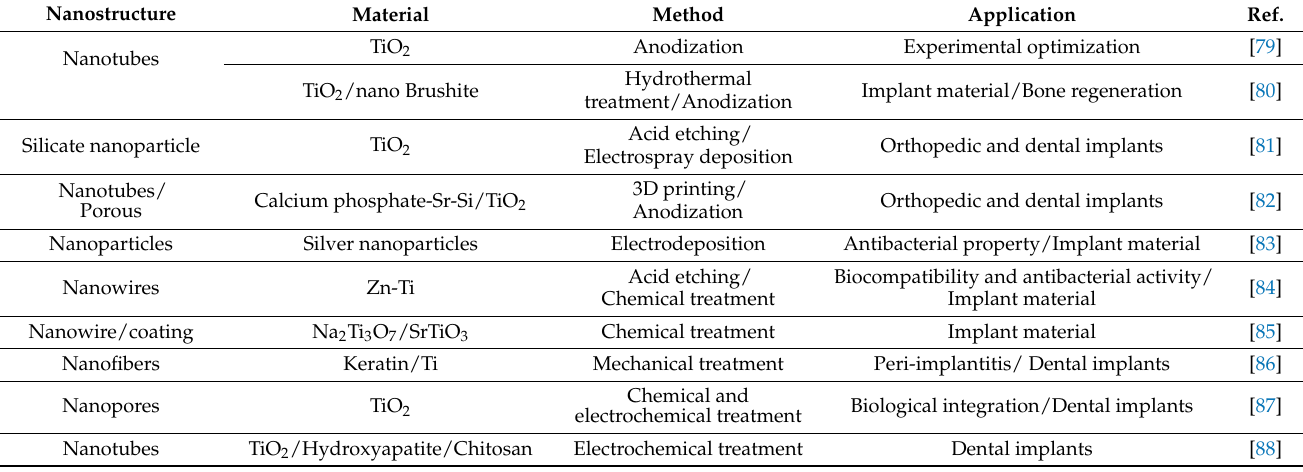
Table 1. Nanostructured modifications on titanium and its